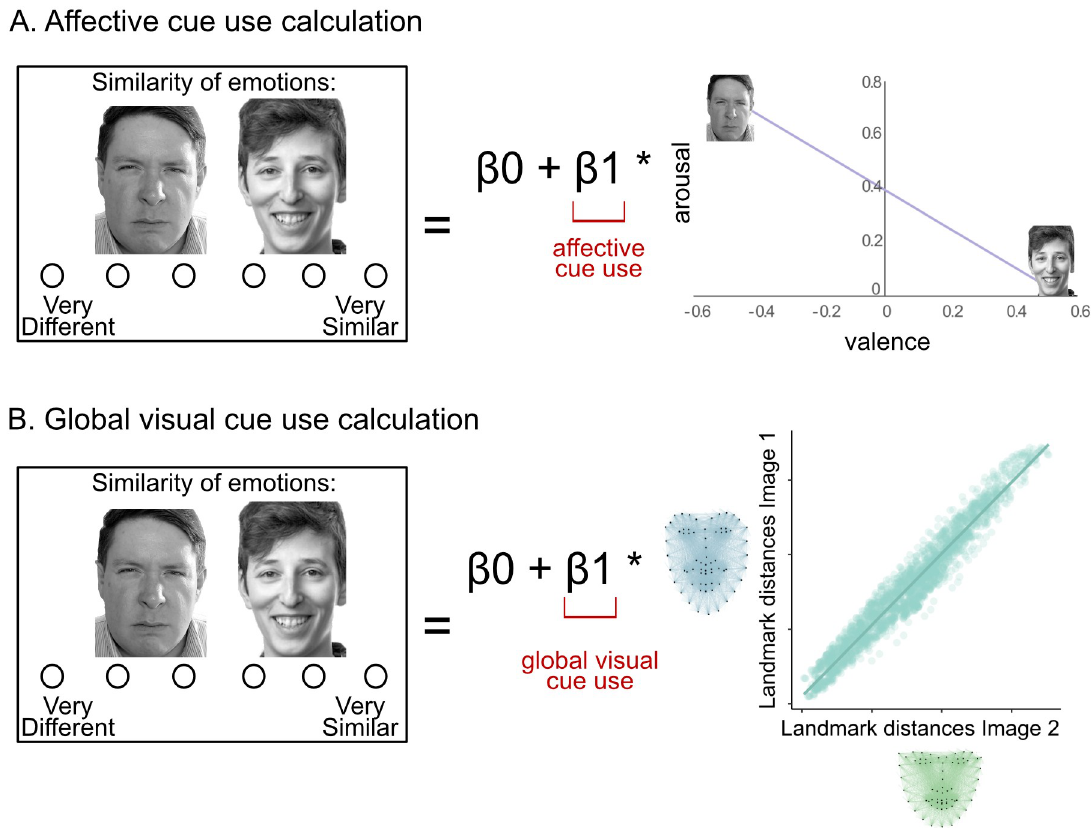
Fig 3. Cue use calculations. The participants’ similarity ratings were predicted by A) the affective similarity score, to calculate the affective cue use score, and B) the visual similarity score to calculate the global visual cue use score.